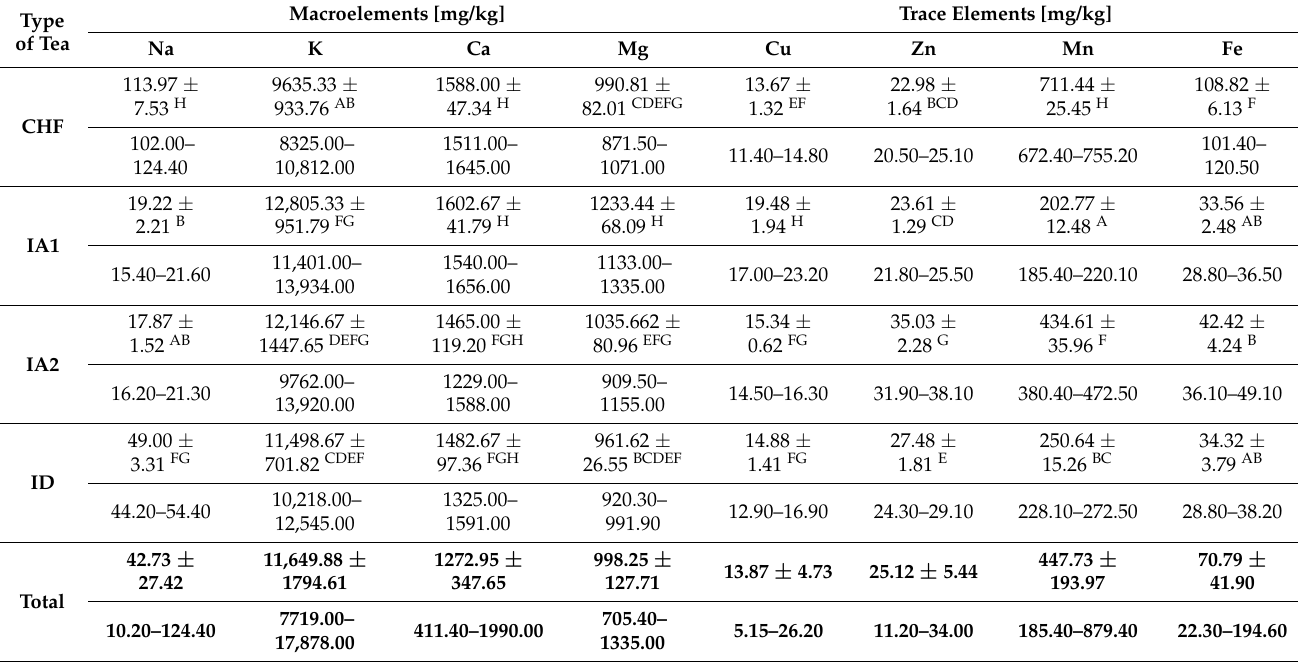
Figure 2. Loadings (on the left ) and scores (on the right ) of first and third components of principal component analysis (PCA). The first ingredient (PC1) separated two groups of teas. The first group represented tea samples of the type Ir, ChF, and SLC, as the samples containing high contents of Fe, Cu, Na, and Mn. The second group included JO, JS and NI3 teas, which contained a small amount of the elements, i.e., Ca, Mg, Fe, and Cu (a similar group was obtained by analyzing the second component (PC2)).